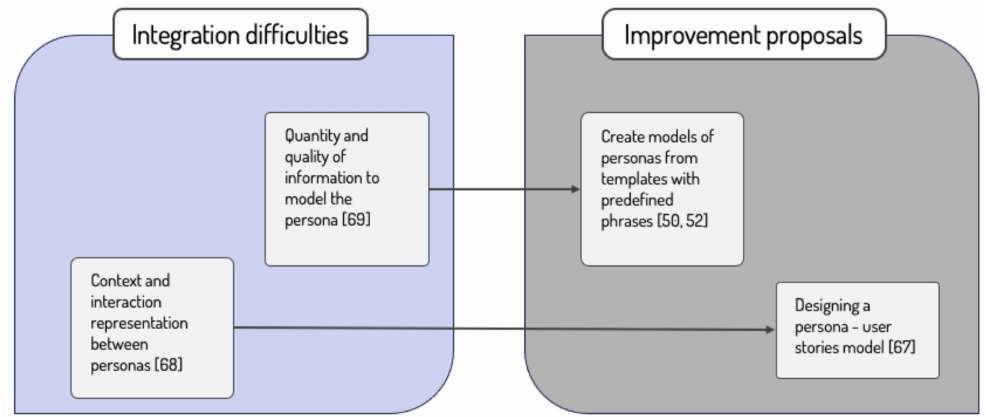
Figure 3. Integration limitations and proposed improvements (answer to